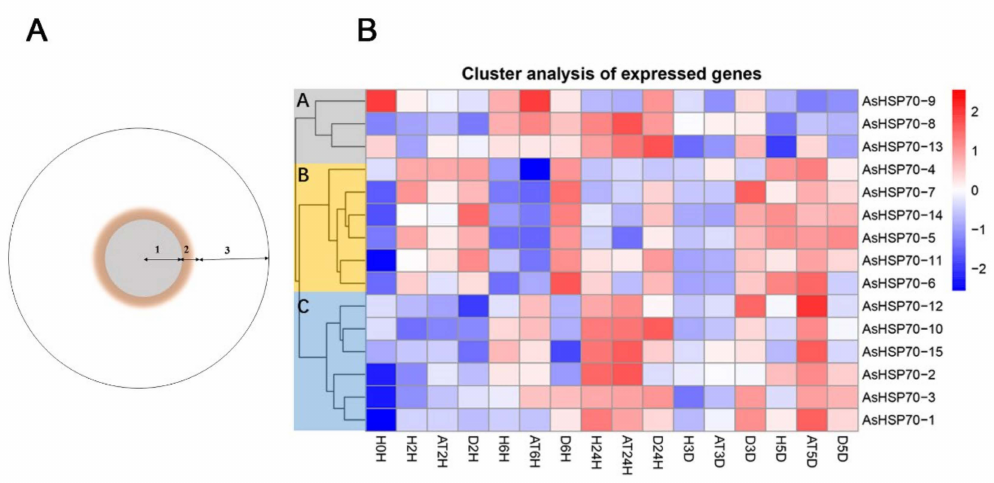
Figure 8. Heat map of the AsHSP70 genes expression profile in different times under Agar- Wit treatment and different layers of agarwood in cross section of A. sinensis tree. ( A ) 1. the decayed layer after Agar-Wit treatment (D); 2. the agarwood and transition layer (AT); 3. the healthy layer (H). ( B ) All gene expression levels were transformed to scores ranging from − 2 to 2 and were colored blue, white or red to represent low, moderate, or high expression levels,